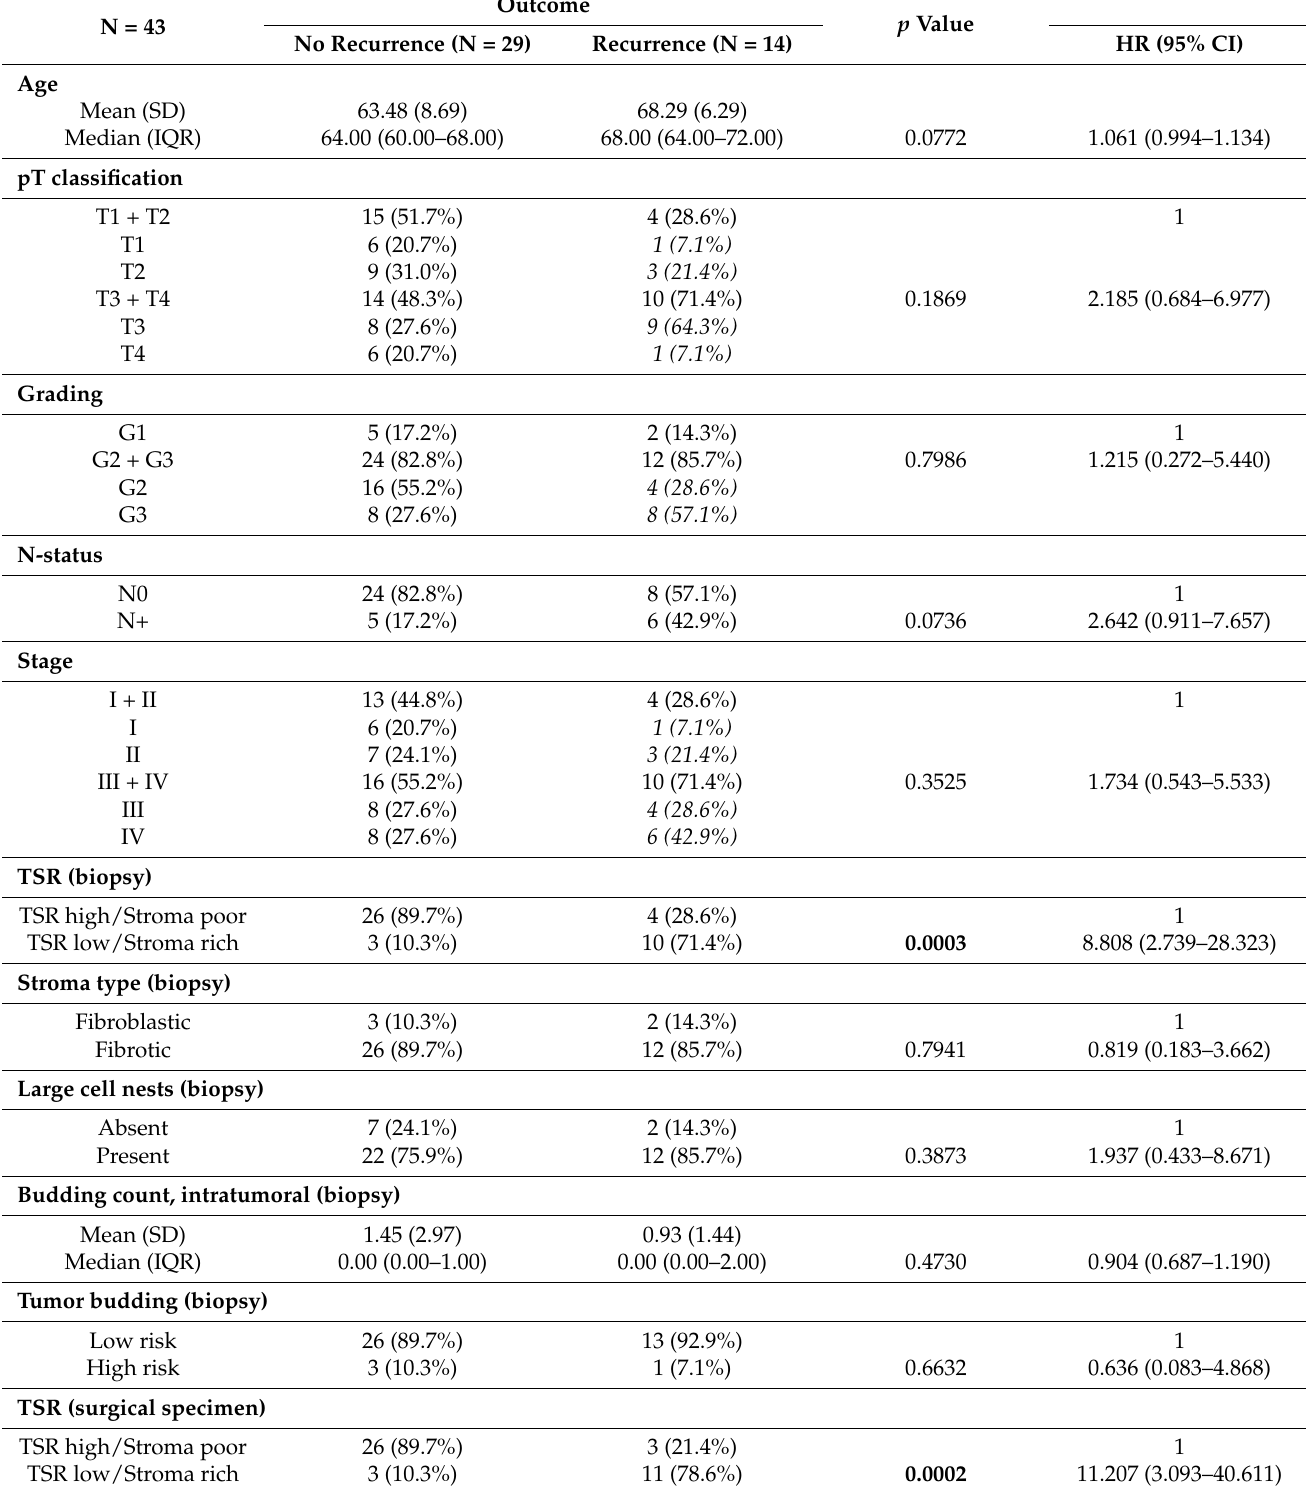
Table 3. Prognostic value of clinical–pathological variables (univariate Cox’s regression